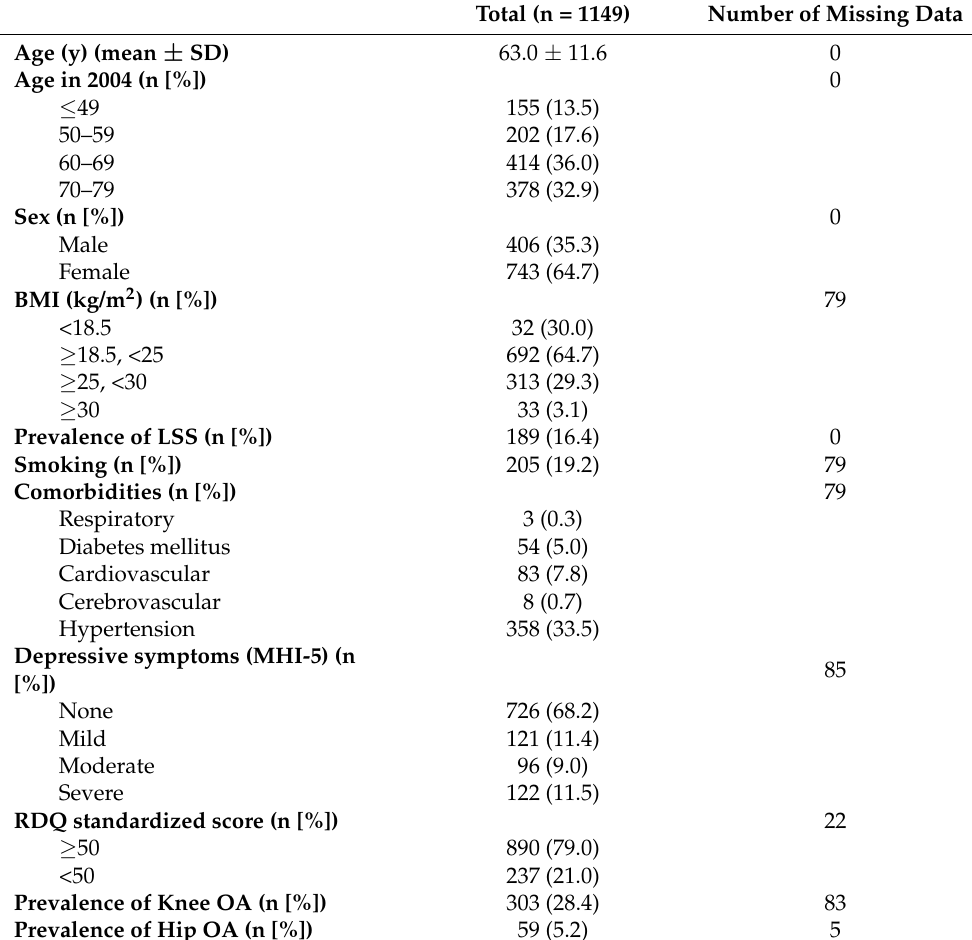
Table 1. Demographic characteristics of participants at initial